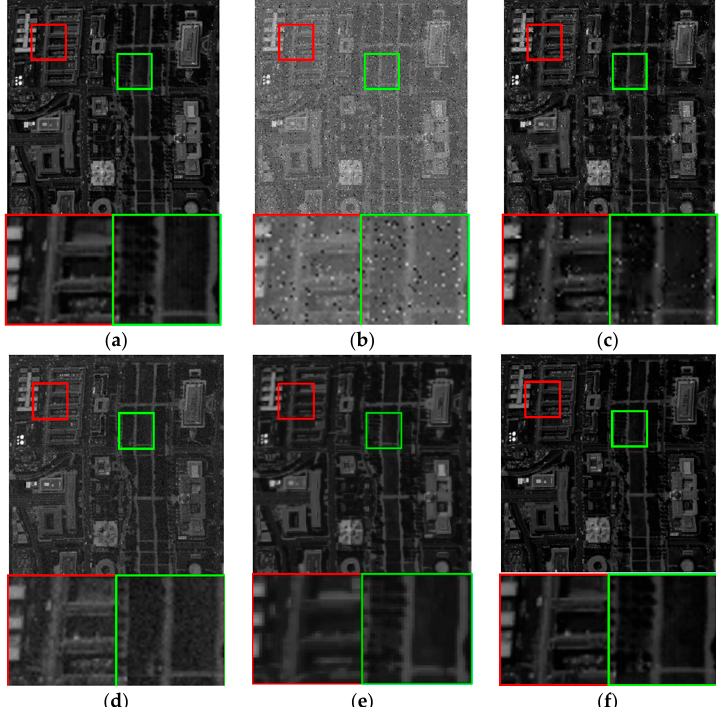
Figure 3. Visual comparison on band 2 of Washington dataset: ( a ) Clean / noise-free image band, ( b ) Noisy band, ( c ) Restoration result from VBM3D, ( d ) Restoration result from Godec, ( e ) Restoration result from SLrank, ( f ) Restoration result from the proposed